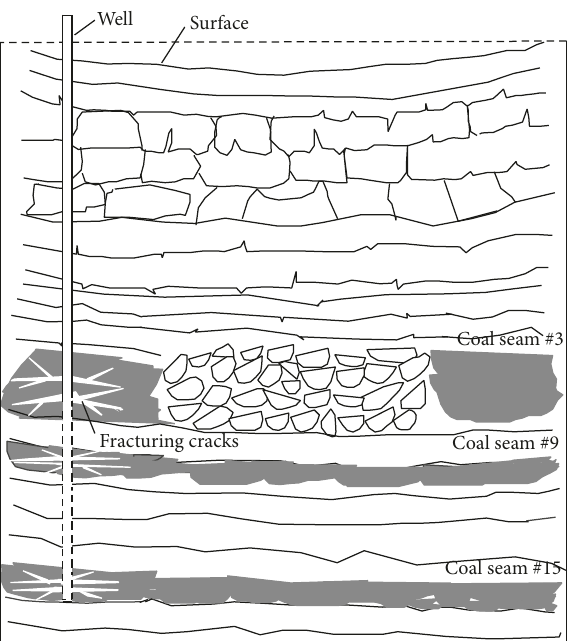
Figure 7: Schematic of the methane extraction through a coal pillar using hydraulic fracturing.